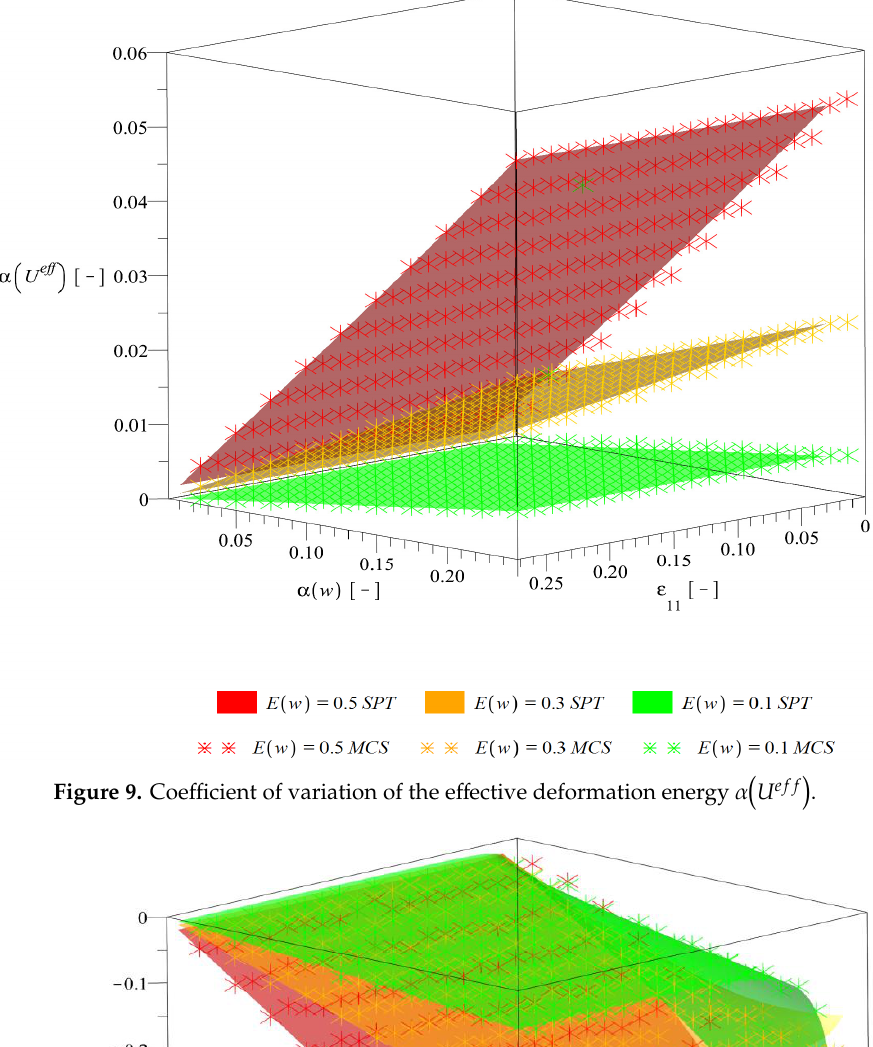
Figure 8. Expected value of the effective deformation energy 𝐸(cid:3435)𝑈 (cid:3032)(cid:3033)(cid:3033) (cid:3439).